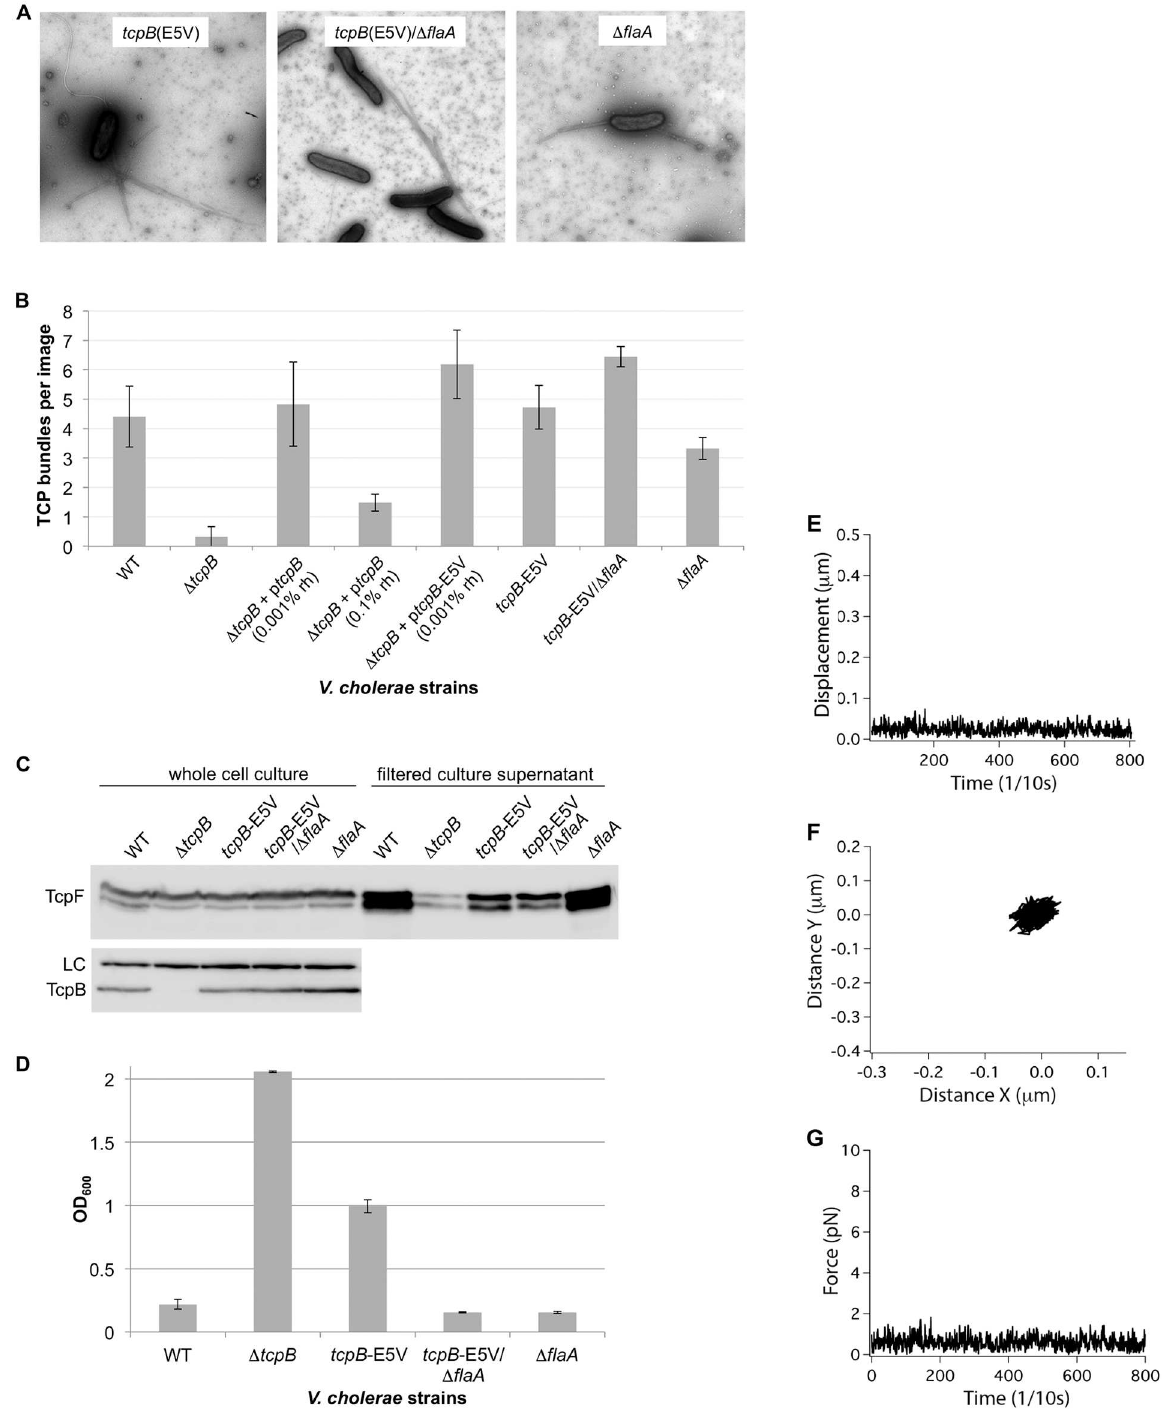
Fig 7. Autoagglutination, TcpF secretion and retraction but not TCP assembly are impaired in a chromosomal tcpB -E5V V . cholerae mutant. (A) TEM images of piliated V . cholerae chromosomal tcpB -E5V/ flaA mutants. (B) TCP bundlesin TEM images were countedto quantify pilus expressionin the various V . cholerae strains. Sixteen or more low magnification (1850X)images were counted for three growth replicatesfor each strain; error bars representstandard deviations. (C) Immunoblots of TcpF and TcpB in whole cell culture and cleared culture supernatant for tcpB -E5V/ flaA mutants. The Glu5Valsubstitutiondisrupts TcpF secretionwithout affecting TcpB production. (D) The Glu5Valsubstitutionin TcpB disrupts autoagglutination,which is restored in the tcpB -E5V/ flaA